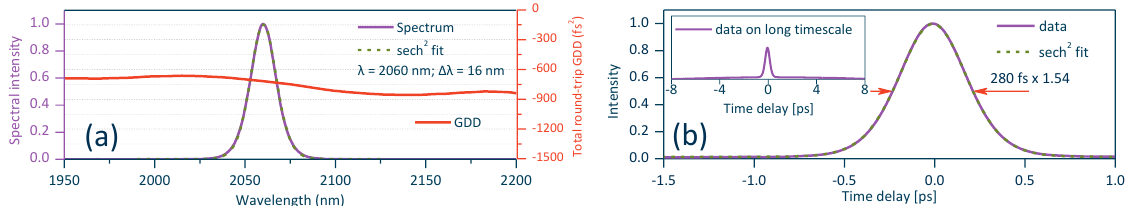
Fig. 1 Optical spectrum (a) and autocorrelation trace (b) of the SESAM mode-locked Tm:(Lu,Sc) with T OC = 3%. Solid red curve in (a): total round-trip GDD. Inset in (b): long-timescale (± 8 ps) autocorrelation